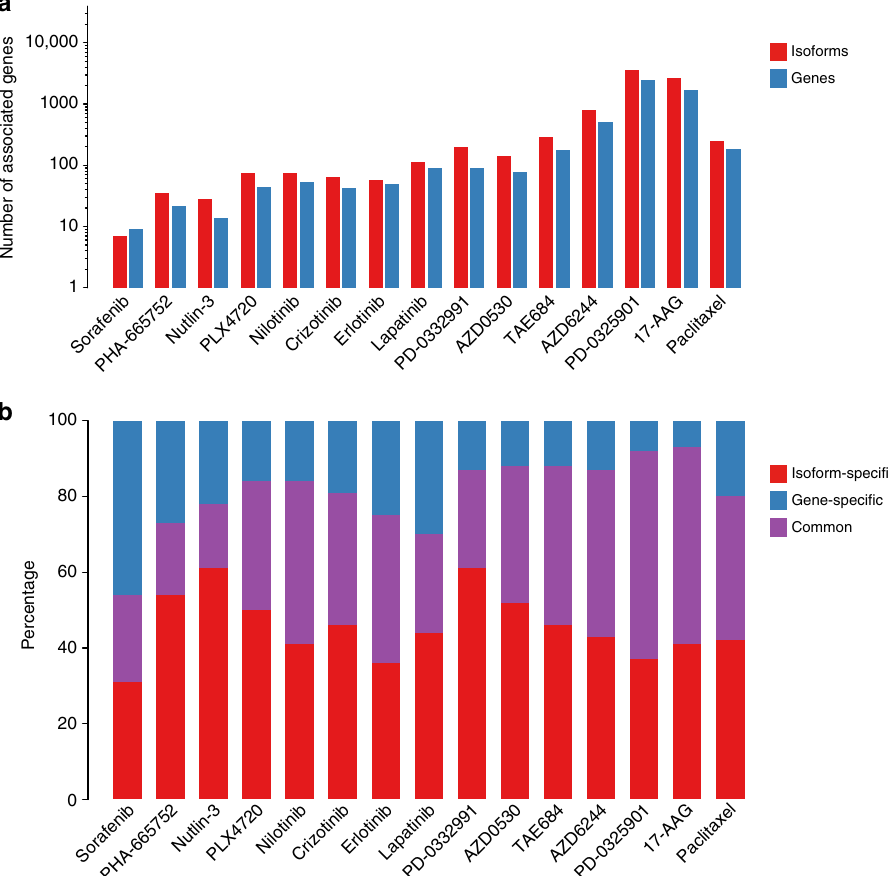
Fig. 2 Comparison of number of statistically signi fi cant (FDR < 1%) predictive biomarkers for each of the 15 drugs in common between CCLE and GDSC. a Number of signi fi cant associations for gene and isoform models. The associations are compared at gene level, i.e., only one isoform is considered for each gene. b Proportion of biomarkers that are signi fi cant at the gene level, isoform levels, or